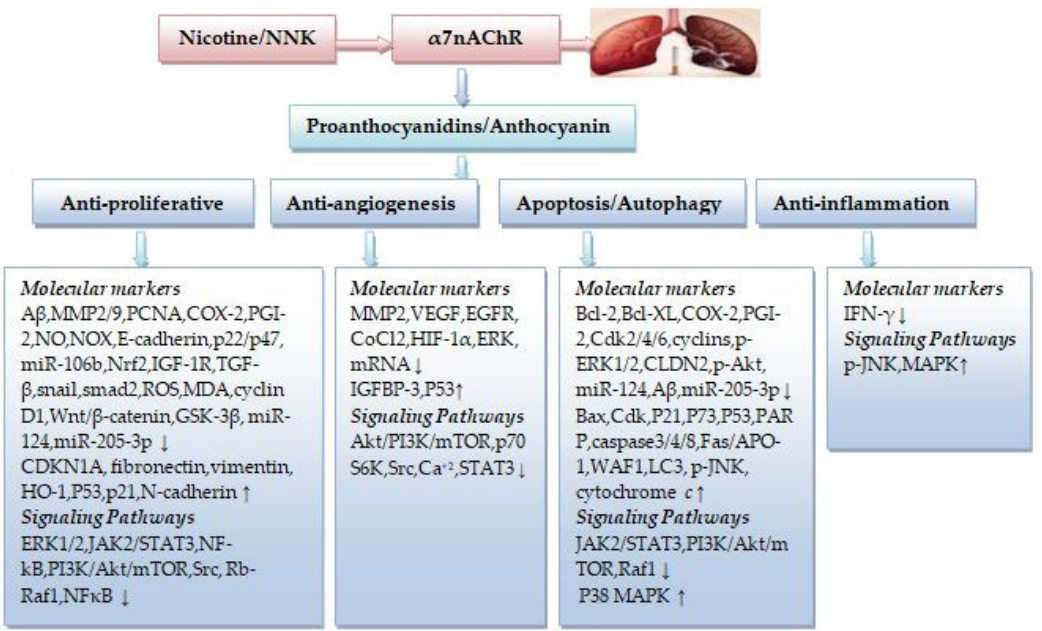
Figure 2. The therapeutic potential of PCs and ACNs in nicotine-induced NSCLC. ( ↓ ) decrease, ( ↑ )